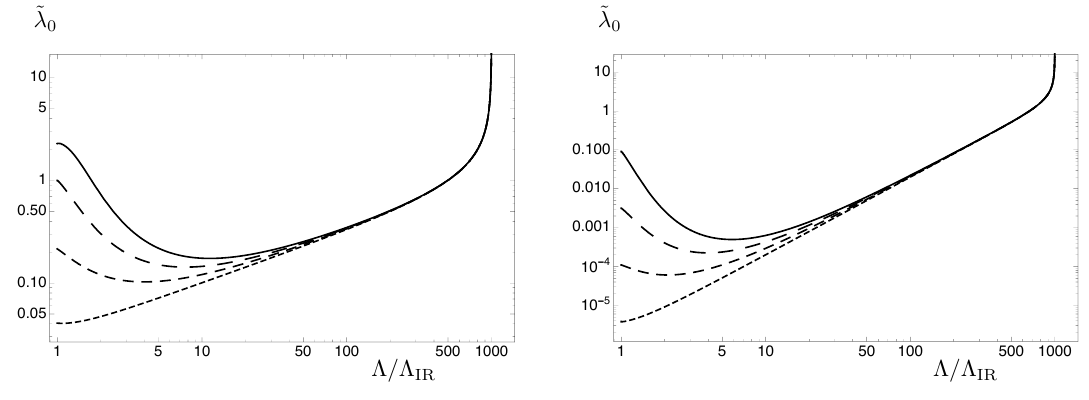
Figure 14 . Model II. The coupling ˜ λ 0 as a function of the energy scale Λ , for ∆ = 3 , x F = 1 , ∆ φ = 1 , and φ c = 1 . 5 . In the left panel ∆ R = 3 and y 5 = 0 , − 1 , − 2 , − 3 (short-dashed to solid lines), while in the right panel ∆ R = 4 . 5 and y 5 = 0 , − 2 , − 4 , − 6 (short-dashed to solid lines). The boundary condition for ˜ λ 0 is chosen such that, for all RG flows shown, the Landau pole is at Λ UV